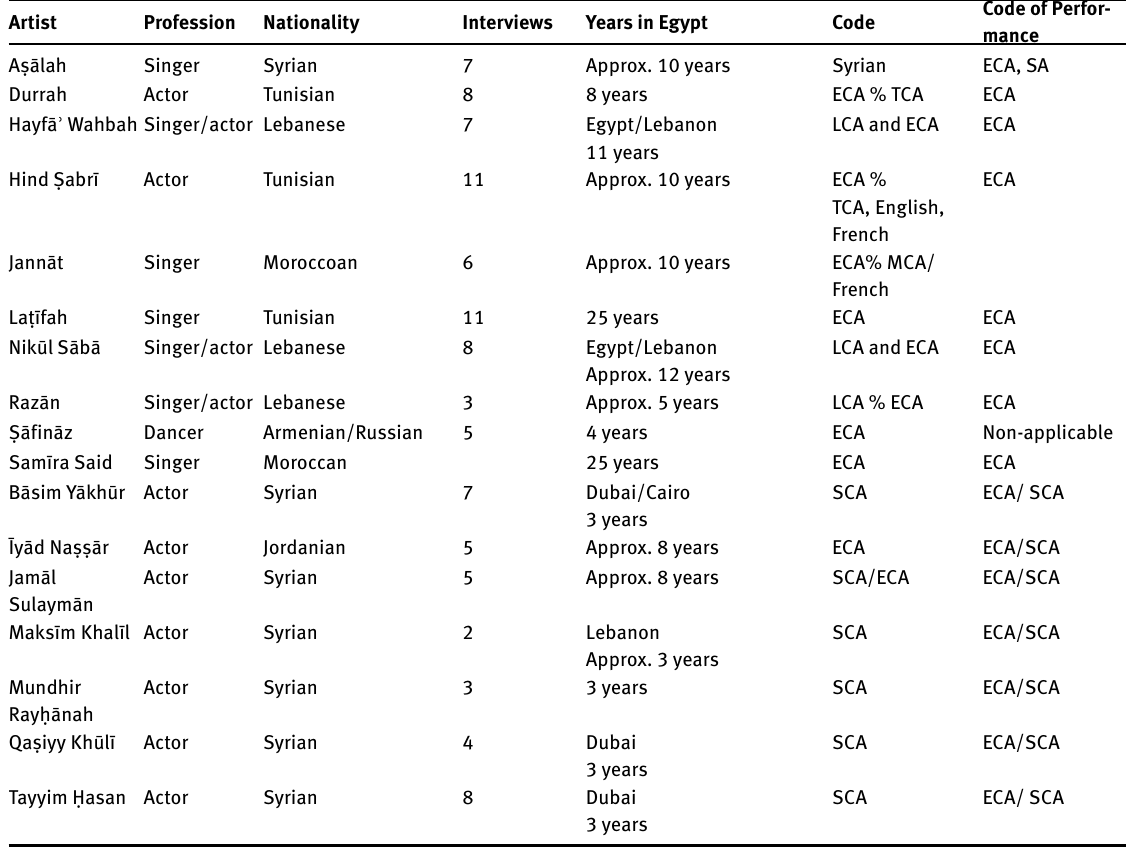
Table 1 Non-Egyptian celebrities’ use of ECA and immigration